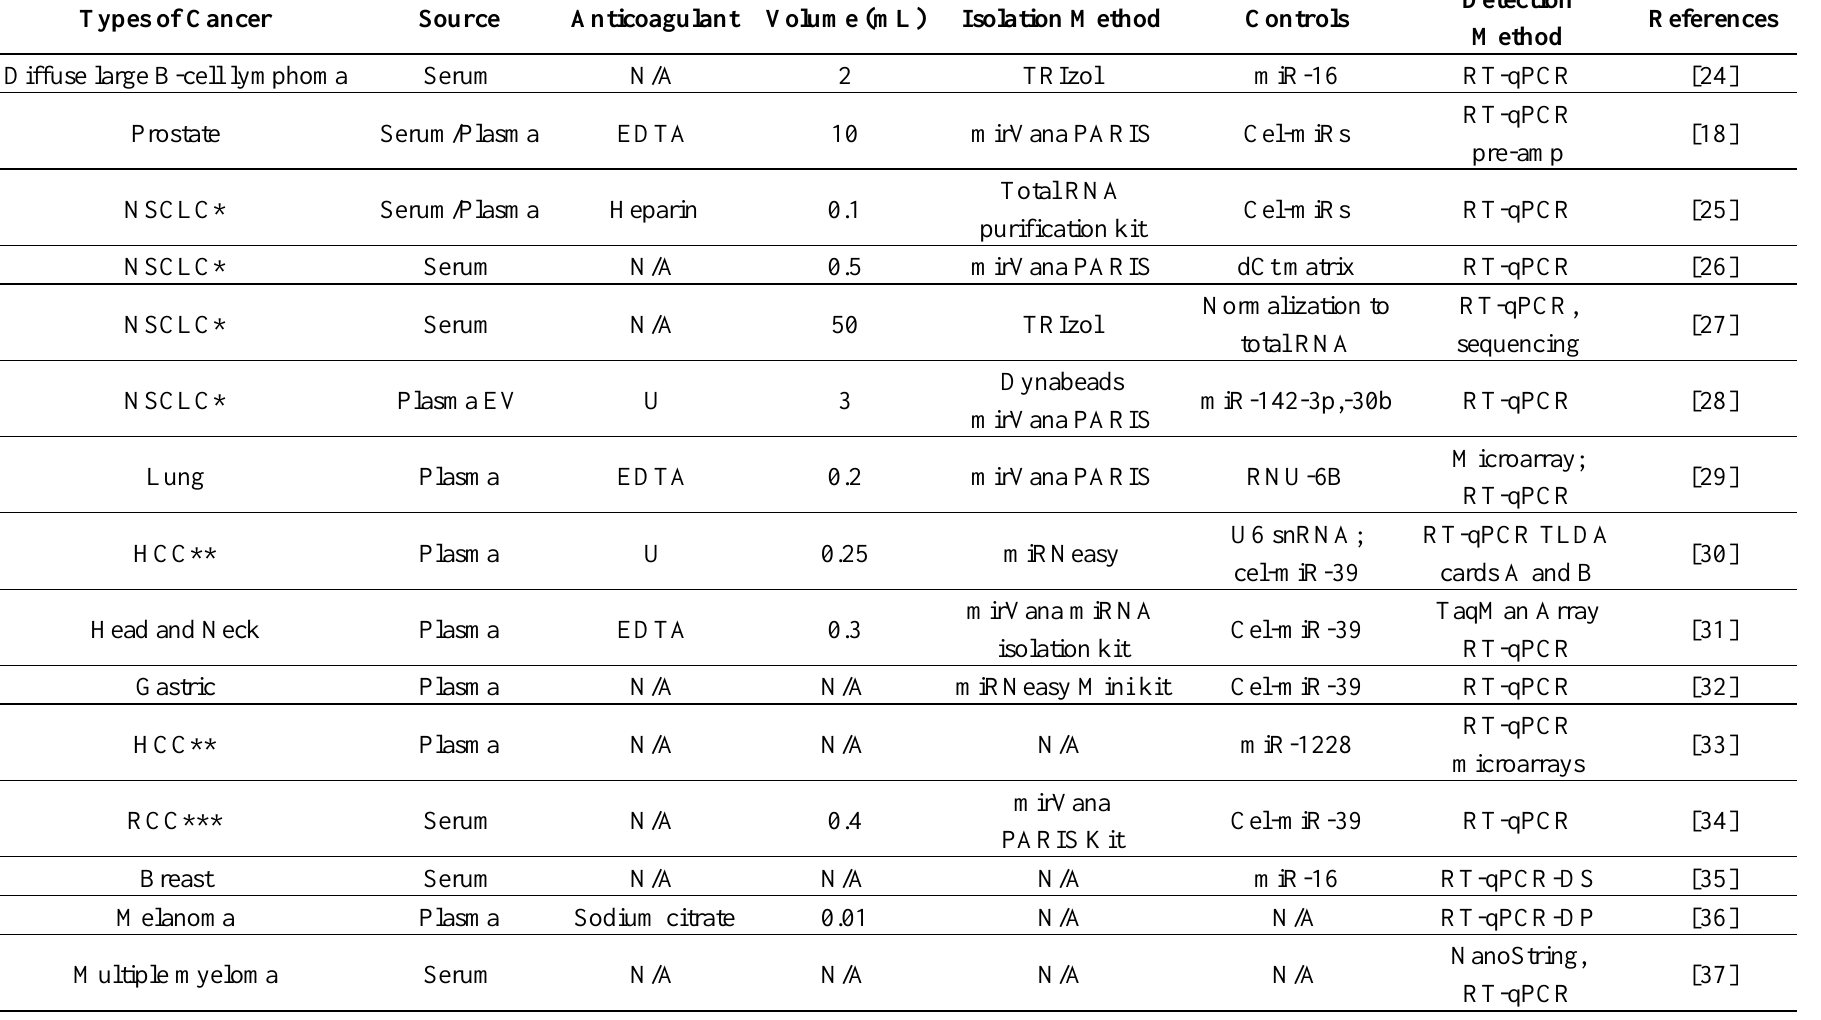
Table 1. Examples of various methodologies for circulating microRNAs